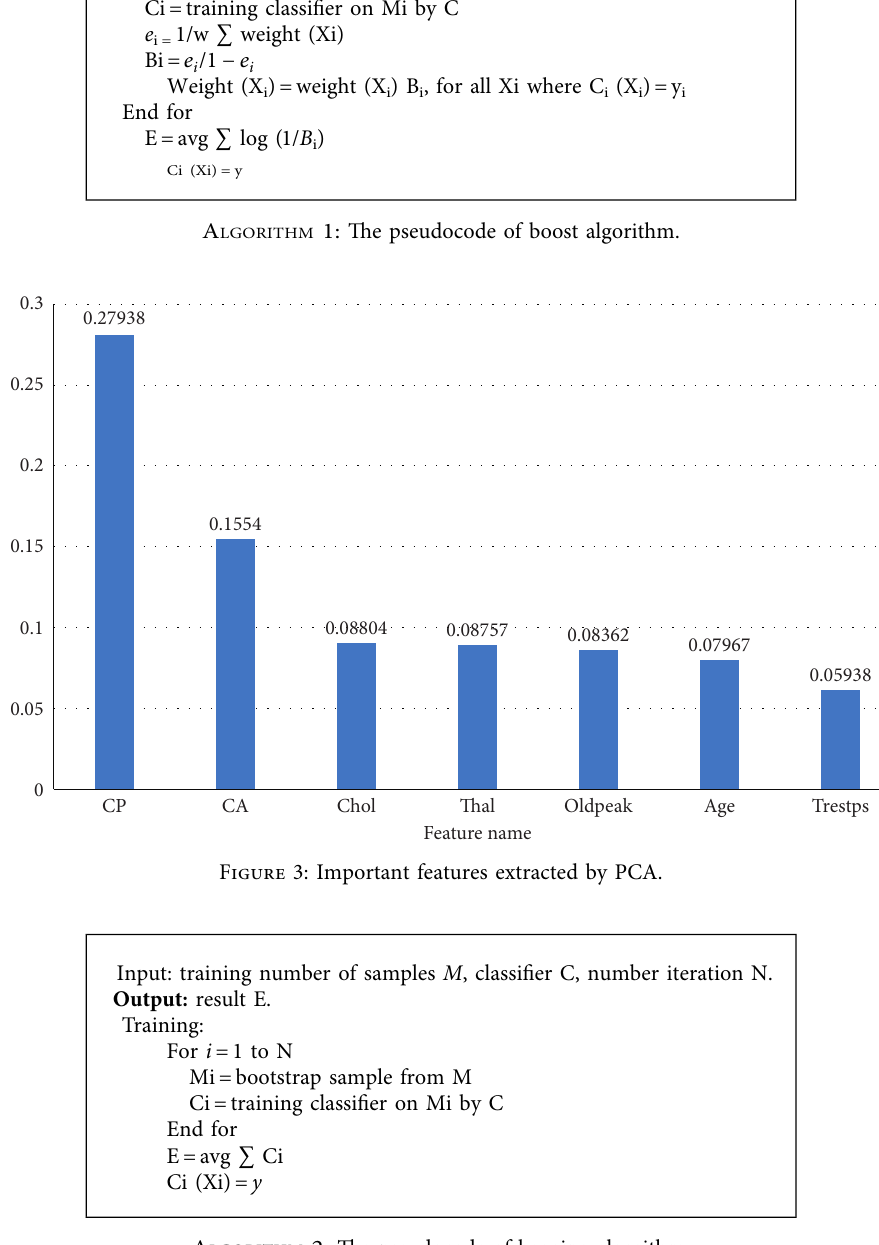
A LGORITHM 2: The pseudocode of bagging